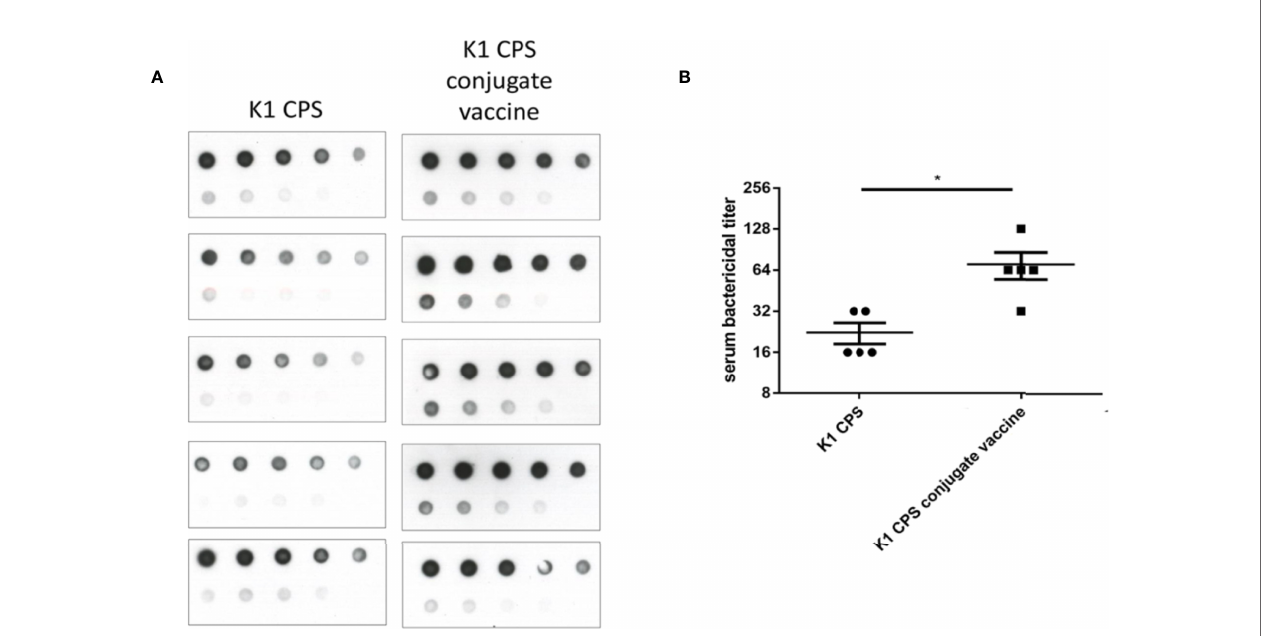
FIGURE 6 | Comparisons of immunization with K1 or K1 CPS conjugated vaccine. The induction of anti-CPS antibodies and serum bactericidal activity in mice received K1 crude CPS (2 m g) or K1 CPS conjugated vaccine (2 m g) were compared. (A) The amounts of anti-K1 antibodies in mice received K1 CPS conjugated vaccine (determined by immunoblotting) were higher than those in mice received K1 crude CPS. (B) Accordingly, the serum bactericidal activity was also signi fi cantly higher in mice received K1 CPS conjugated vaccine. The data were analyzed using the two-tailed unpaired t test. * P <